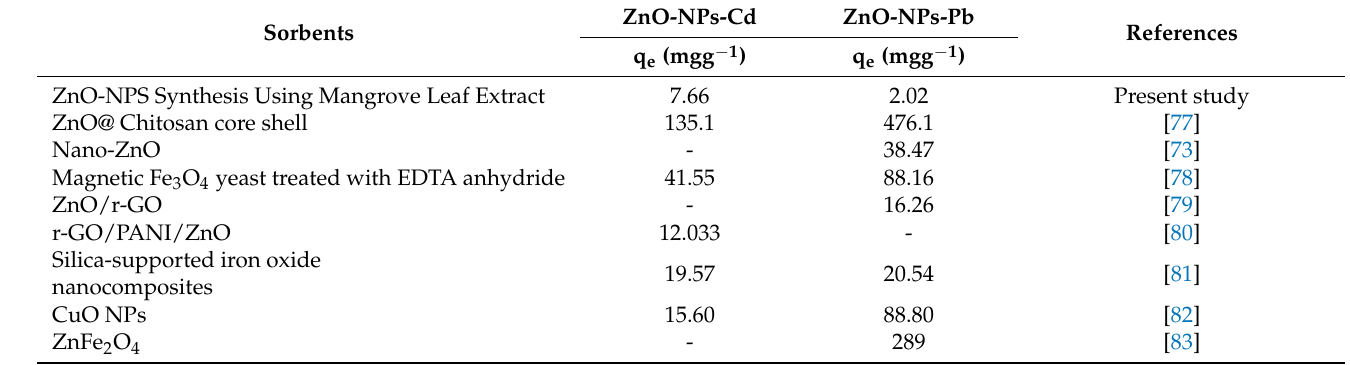
Table 9. Summary of some of the other reported adsorbents used to remove Cd 2+ or Pb 2+ .